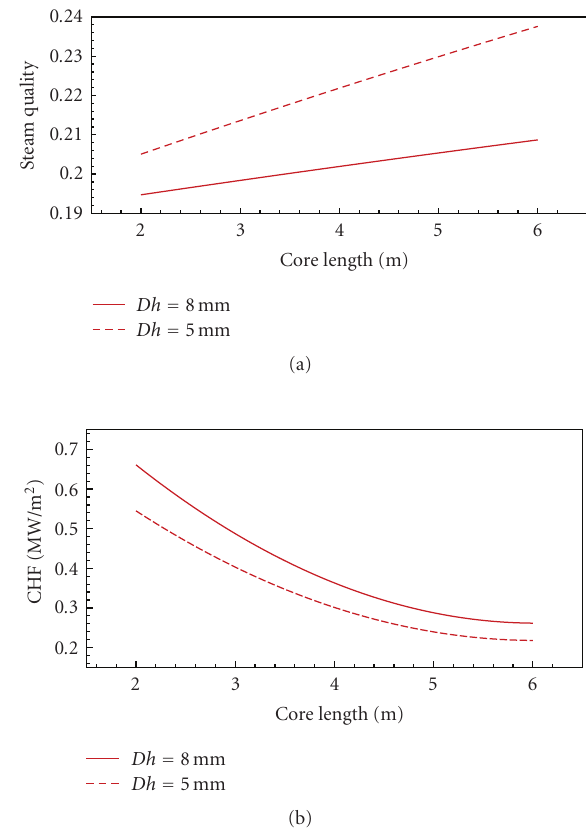
Figure 12: The variations of (a) steam quality and (b) CHF with core